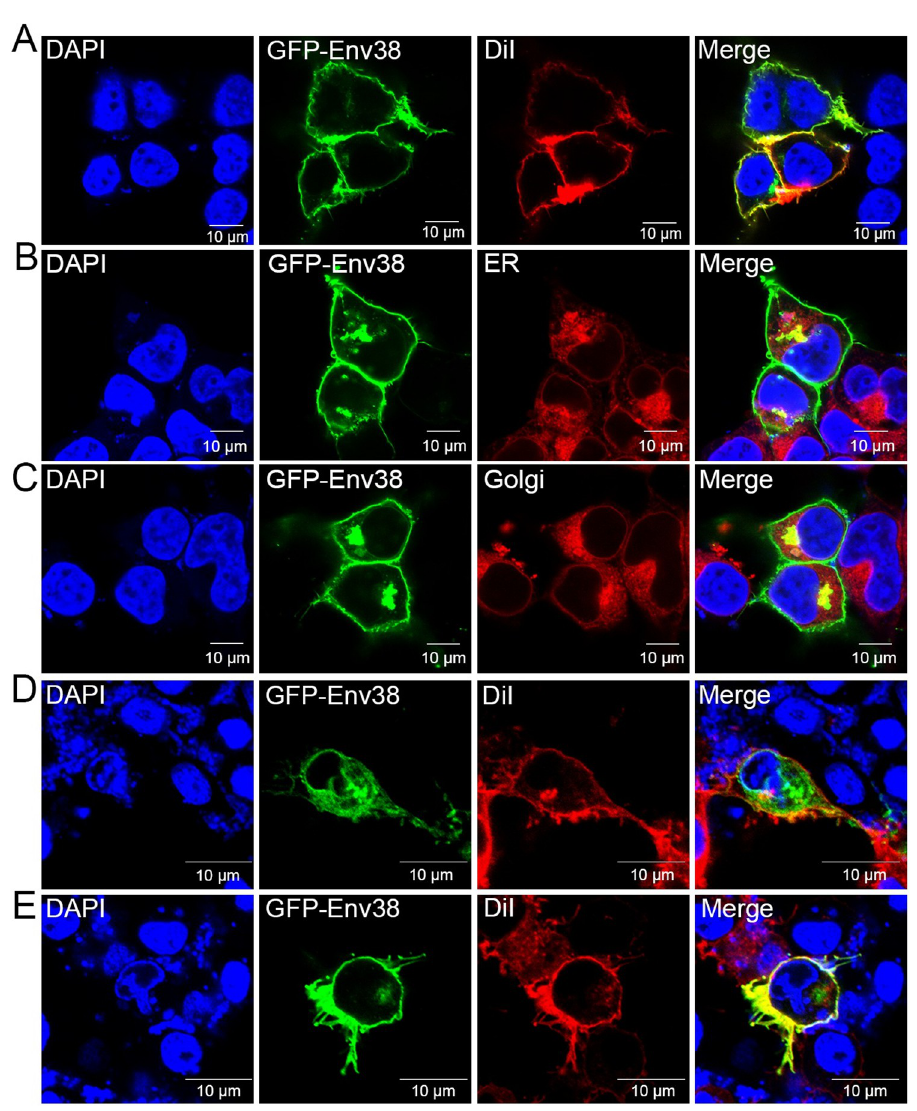
Fig 3. Subcellular localization analysis of Env38 in HEK293T and EPC cells. (A-C) HEK293T cells were transfected with the recombinant expression plasmid of pEGFPN1-Env38 (0.6 μ g/ml) for 48 h, and then fixed and stained with the cell membrane probe DiI (A), ER-tracker (B) or Golgi-tracker (C) and nuclei probe DAPI. (D and E) EPC cells were transfected with the recombinant expression plasmid of pEGFPN1-Env38 (0.6 μ g/ml) for 24 h and stimulated with SVCV (100 TCID 50 ) (E) or not (D) for another 24 h, and then fixed and stained with the cell membrane probe DiI and nuclei probe DAPI. The blue, green, and red fluorescence showed DAPI-labeled nuclei, Env38–EGFP fusion protein, and DiI–labeled cell membrane or ER-tracker–labeled ER or Golgi-tracker–labeled Golgi apparatus. Fluorescence images were captured using Laser scanning confocal microscope (FV3000) with 60 × oil glass.